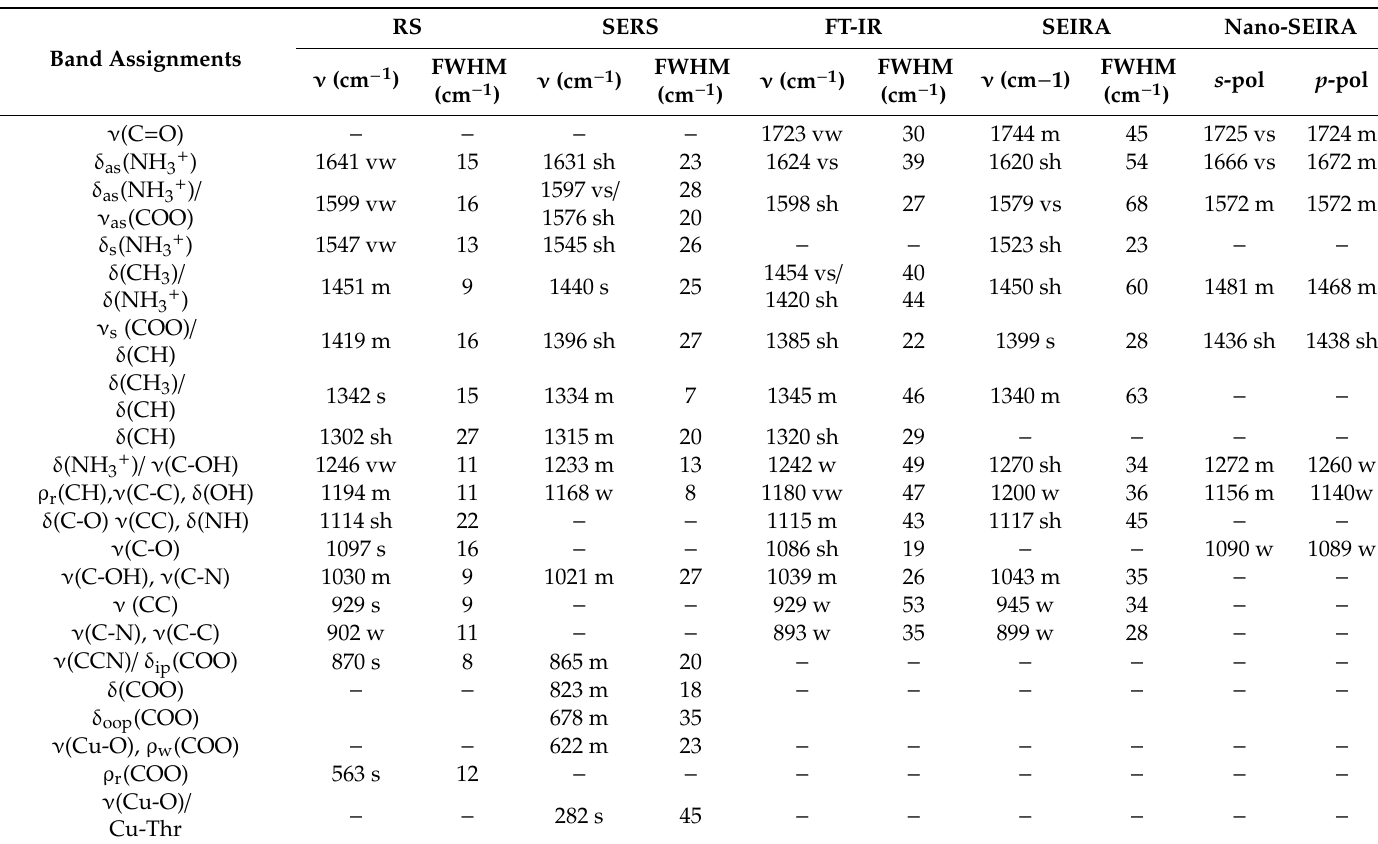
Table 1. Wavenumber and proposed band assignments for Raman spectroscopy (RS), surface-enhanced Raman spectroscopy (SERS), Fourier-transform infrared (FT-IR), surface-enhanced infrared absorption spectroscopy (SEIRA), and nano-SEIRA spectra of Thr (10 − 1 M) adsorbed onto the corroded CuNPs-Fe